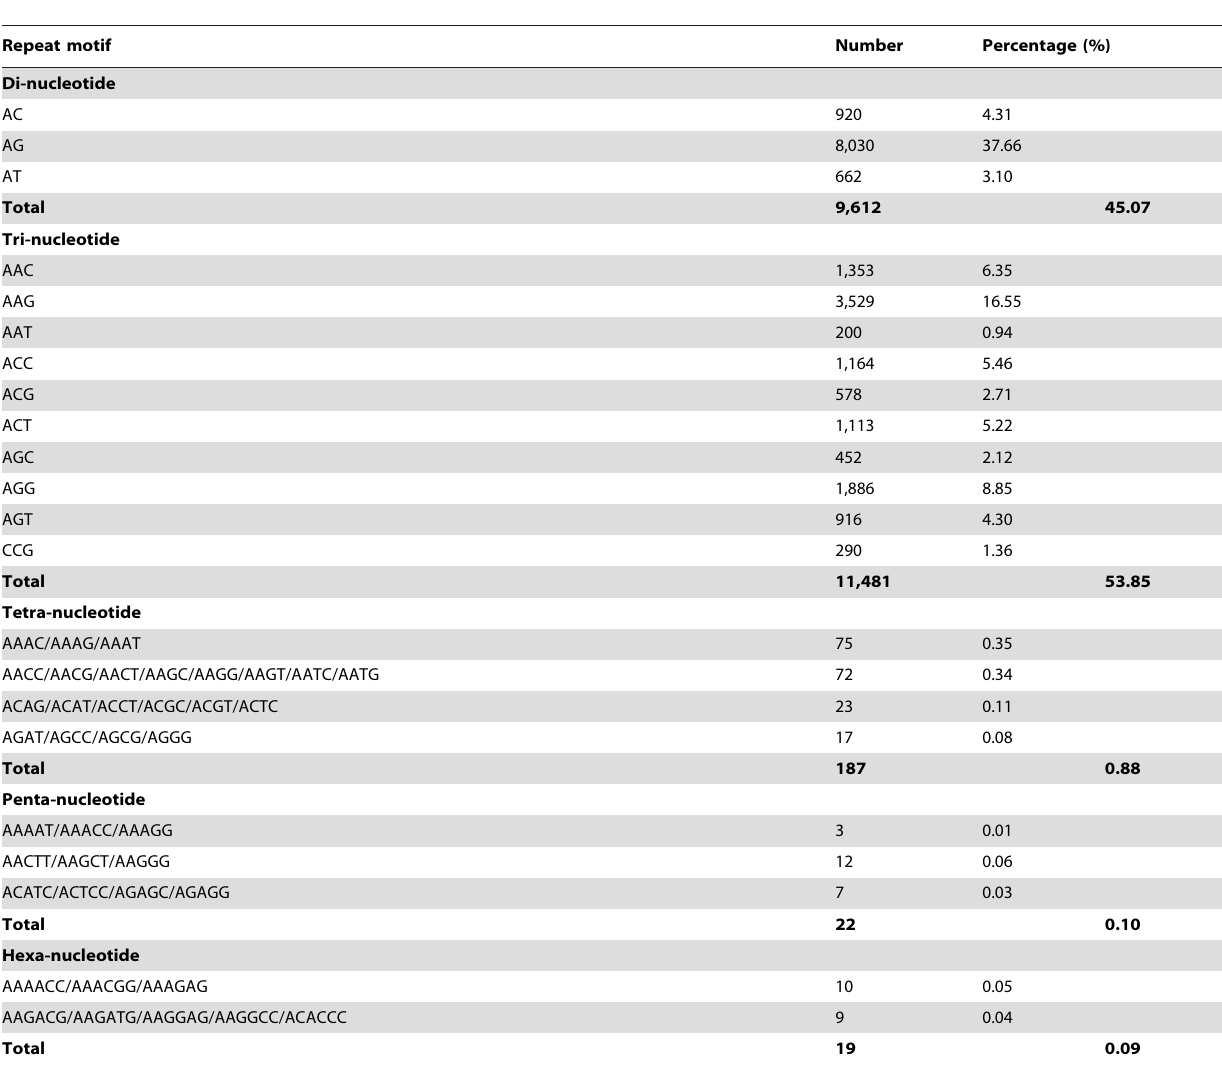
Table 3. Summary of simple sequence repeat (SSR) types in the S. arvensis transcriptome.